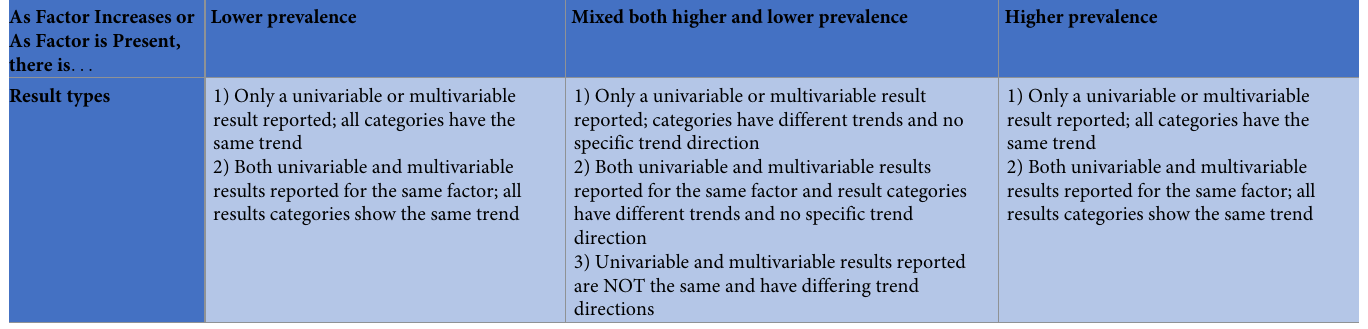
Table 2. Data synthesis measurement summary. As Factor Increases or As Factor is Present, there is